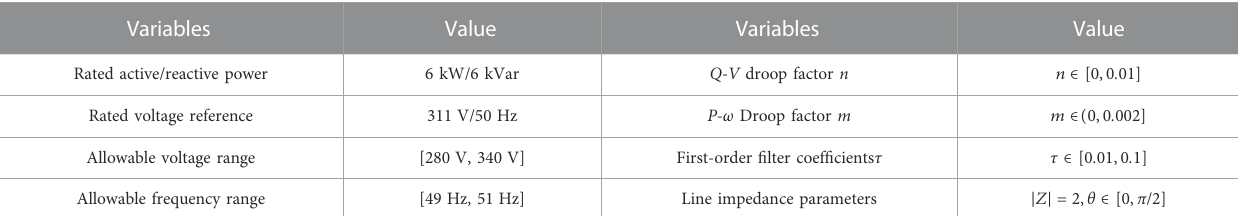
TABLE 3 Physical and control parameters of the inverter.